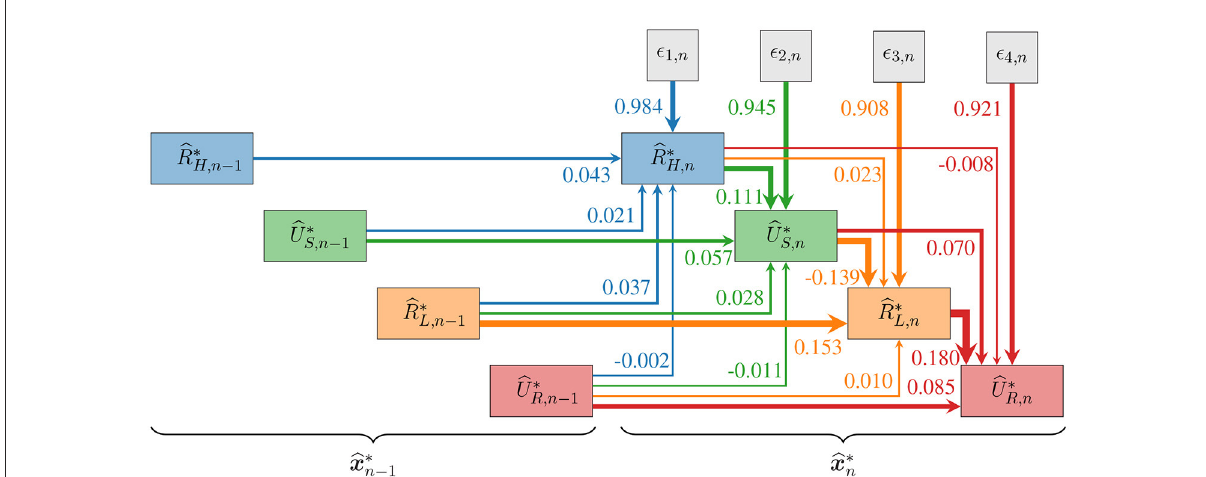
FIGURE9 A weighted graph displaying the causal structure of the utilized SVAR( p ) process, showing the nearest temporal contributions to realizations of the random vector x ∗ n . Arrow weights show the model parameters contained in A , B and the upper triangular part of C 1 when fit with p The actual SVAR( p ) model uses many more connections than shown (16 p variables within cycle range p b